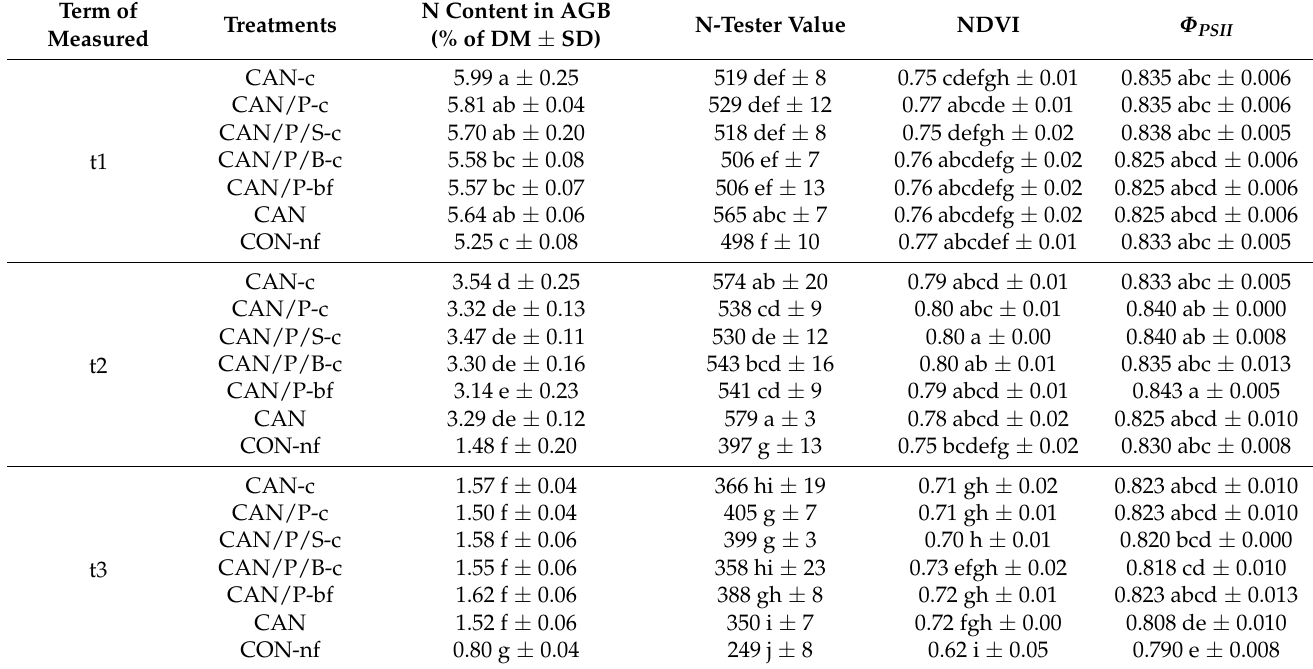
Table 7. Nitrogen content in the above-ground mass of maize plants (% DM), N tester value, NDVI, and quantum yield of photosystem II ( Φ PSII ) in maize. The values represent the mean (n = 4) ± standard deviation. Different letters denote statistically significant differences among treatments using Tukey’s post hoc tests. CAN-c: 100% CAN with P3HB coating; CAN/P-c: 50% CAN + 50% P3HB with P3HB coating; CAN/P/S-c: 50% CAN + 25% P3HB + 25% struvite with P3HB coating; CAN/P/B-c: 50% CAN + 50% biomass with P3HB coating; CAN/P-bf: 50% CAN + 50% P3HB encapsulated in biodegradable film; CAN: 100% CAN (positive reference); CON-nf: without fertilizer (negative